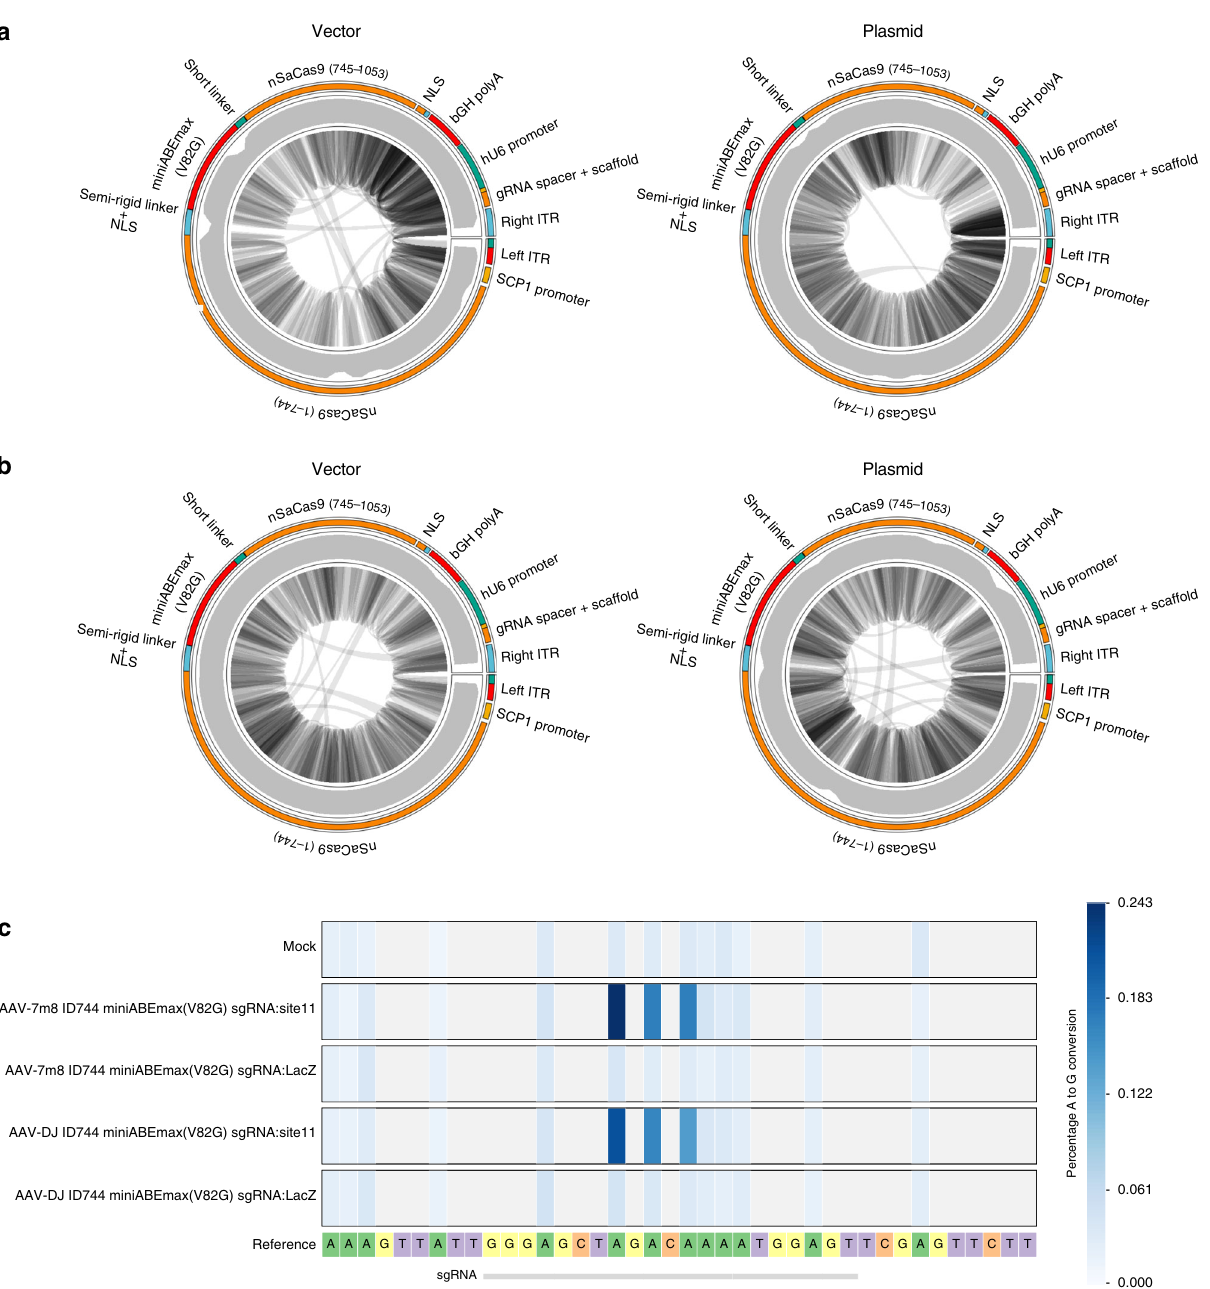
Fig. 4 AAV-mediated delivery of a single construct containing domain-inlaid nSaCas9 I744 (microABE I744) and a sgRNA targeting either ABE site 11 or LacZ. a Schematic showing the all-in-one AAV construct driving the expression of the microABE I744 via an SCP1 minimal promoter and a hU6 promoter for the sgRNA component, with example aligned reads from 7m8-AAV vector and its corresponding plasmid, as well as ( b ) AAV-DJ packaged vector and its corresponding plasmid. c Percentage of A-to-G conversions are presented as an average of three technical replicates, for either the AAV- 7m8 or AAV-DJ serotypes, in HEK293A-YFP cells. Source data are available in the Source data fi